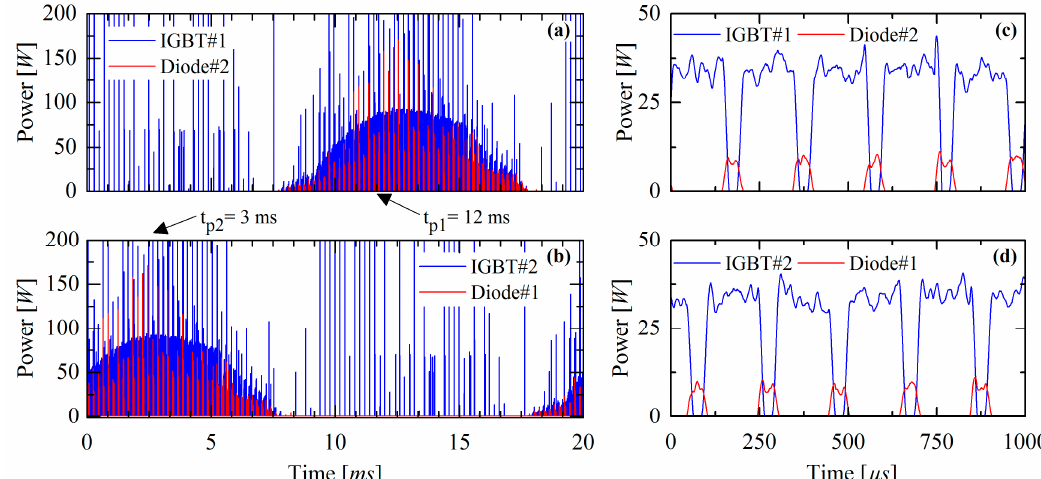
Figure 5. Measurements of the power dissipated by the active devices of the module under test; ( a ) shows the power dissipated by the pair composed by IGBT #1 and Diode #2, while ( b ) illustrates the other ones. A 1 ms window detail of ( a ) and ( b ) are reported in plots ( c ) and ( d ), respectively. In particular, ( c ) is a zoom of ( a ) starting from t p1 = 12 ms, while ( d ) is a zoom of ( b ) starting from t p2 = 3 ms.